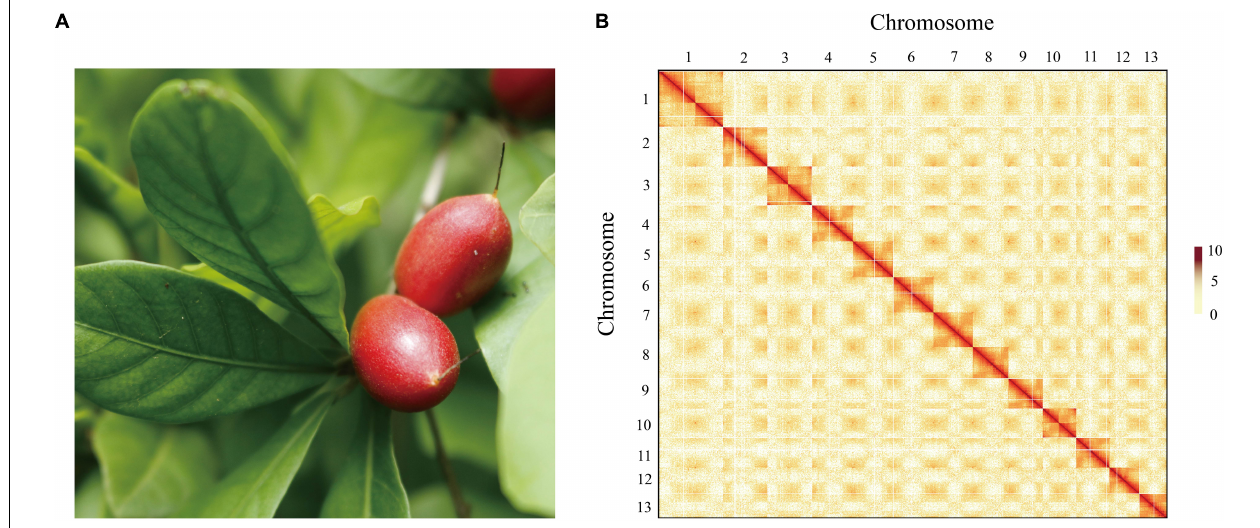
FIGURE 1 | The morphology of the berry and Hi-C-assisted genome assembly of S. dulcificum . (A) The fruit of the sequenced S. dulcificum . (B) Hi-C interaction heatmap showing 110-kb resolution chromosome.